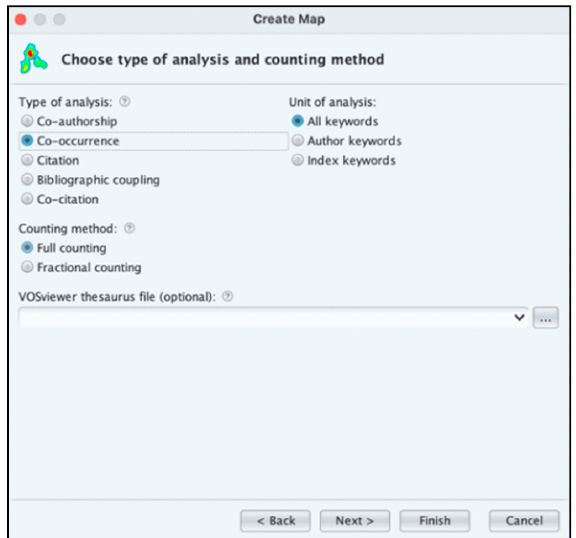
Figure A3. Selected “co-occurrence” on the left first then select “all keywords” on the right.